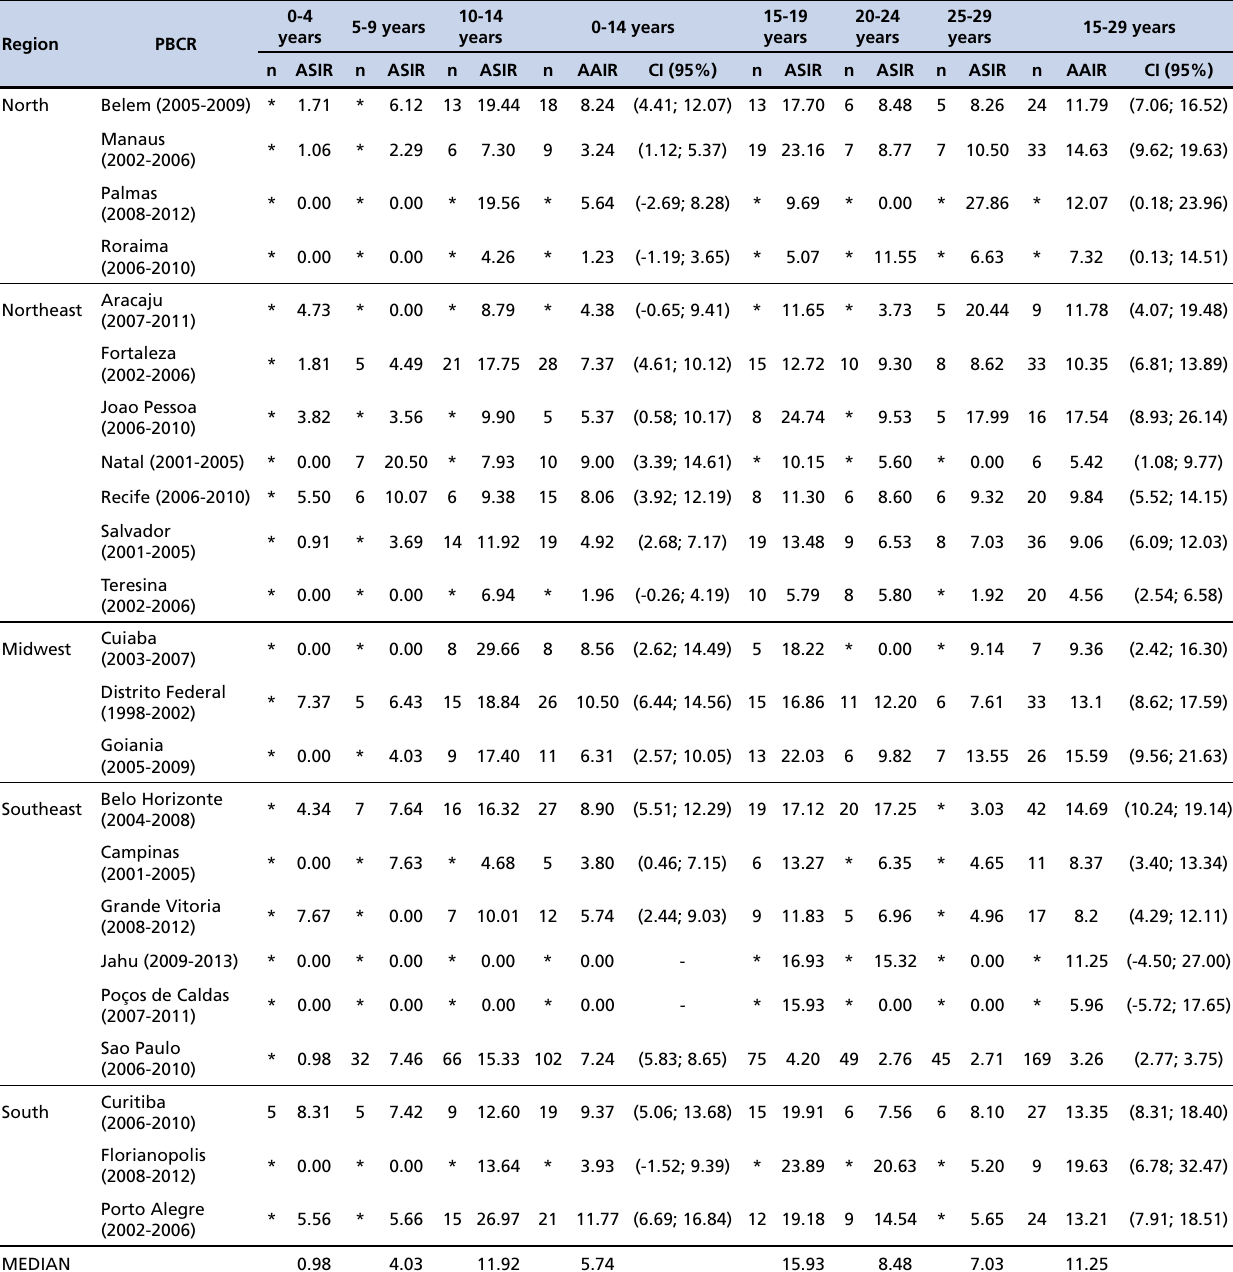
Table 1 – Incidence rates per million (ASIR; AAIR) of bone tumors in children, adolescents, and young adults according to age group and